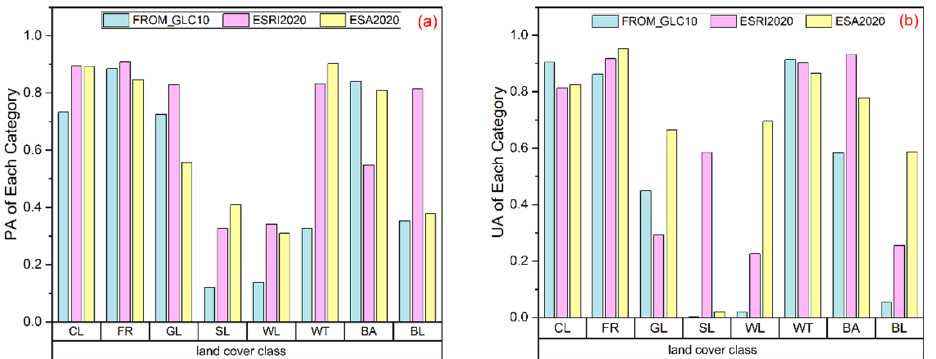
Figure 9. Accuracy of the eight main classes: cropland (CL), forest (FR), grassland (GL), shrubland (SL), wetland (WL), water (WT), built-up area (BA), and bare land (BL). ( a ) Mean PA values of the three land cover products, and ( b ) mean UA values of the three land cover products.